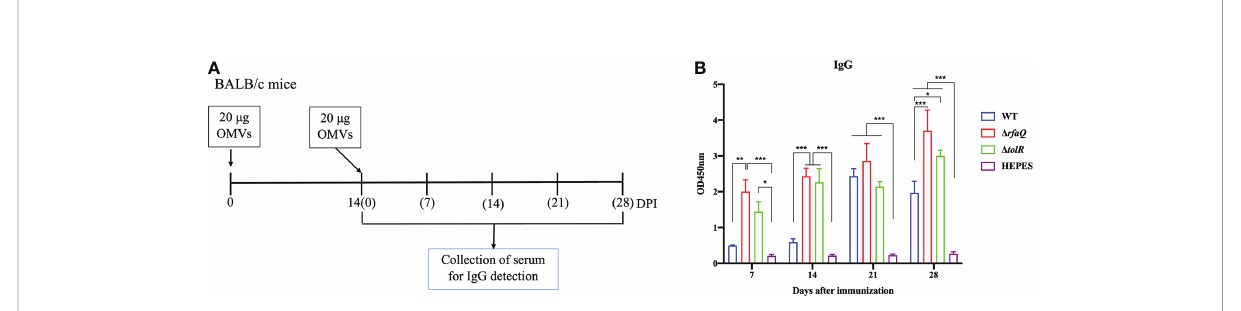
FIGURE 3 Antibody responses induced by S. Enteritidis OMVs. (A) Design of the animal experiment to detect serum IgG levels induced by OMVs. (B) IgG antibody against whole bacterial lysates was detected in serum samples from OMV-immunized mice at 7, 14, 21, and 28 days after immunization. The serum was diluted to 1:800 to assess IgG levels using the lysate of the CMCC50041 strain as a coating antigen in ELISA. The IgG levels in the serum samples were measured at 450 nm. Data are expressed as mean ± SEM. * p ≤ 0.05; ** p ≤ 0.01; *** p ≤ 0.001.